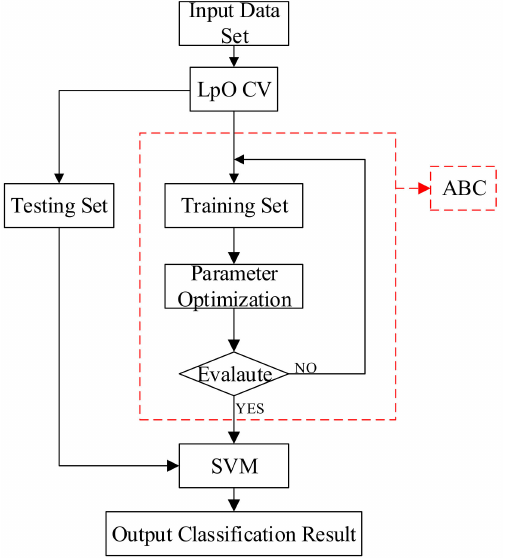
Figure 8. Flowchart of ABC–SVM classification.